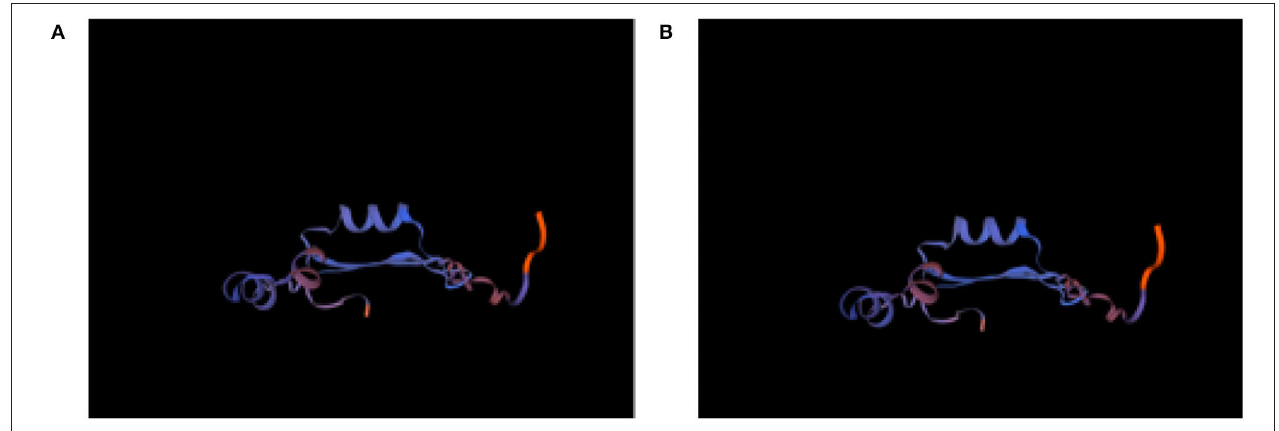
FIGURE 9 | Protein structure of Staphylococcus aureus mecA gene (A) Cat-1 and Cat-2, and (B) Environment, Human, and Cat-3.